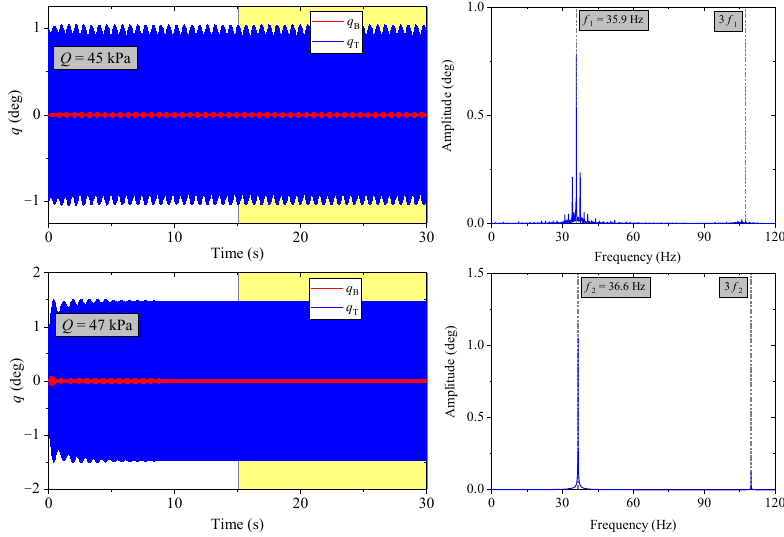
Figure 15. Time responses and spectra for 45 and 47 kPa and δ B / δ T =